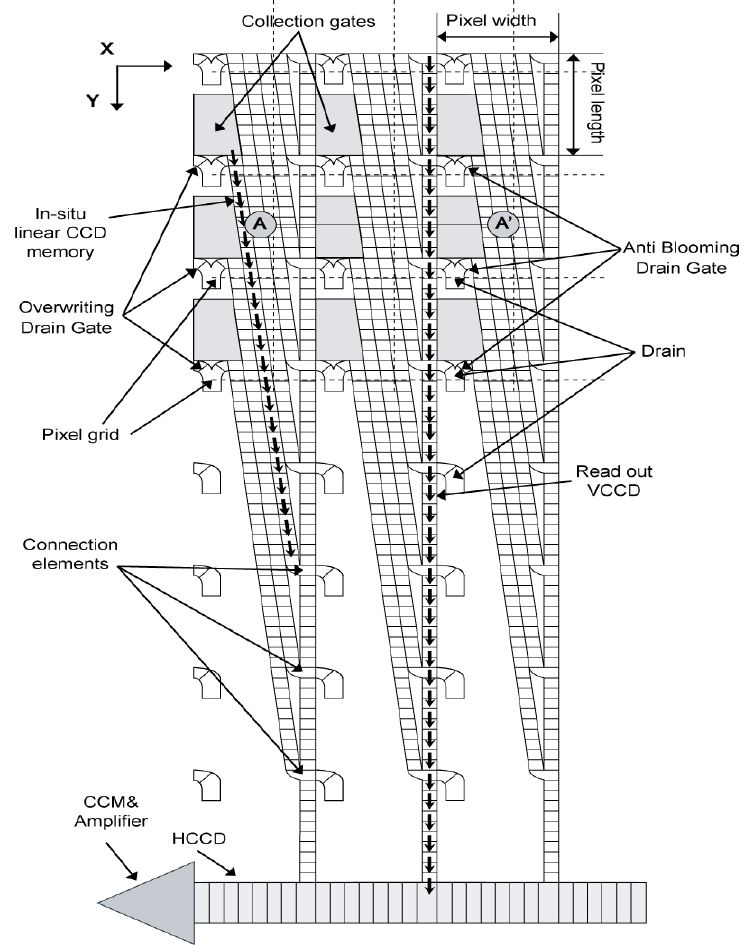
Figure 3. ISIS structure proposed by Etoh et al. [4,5].